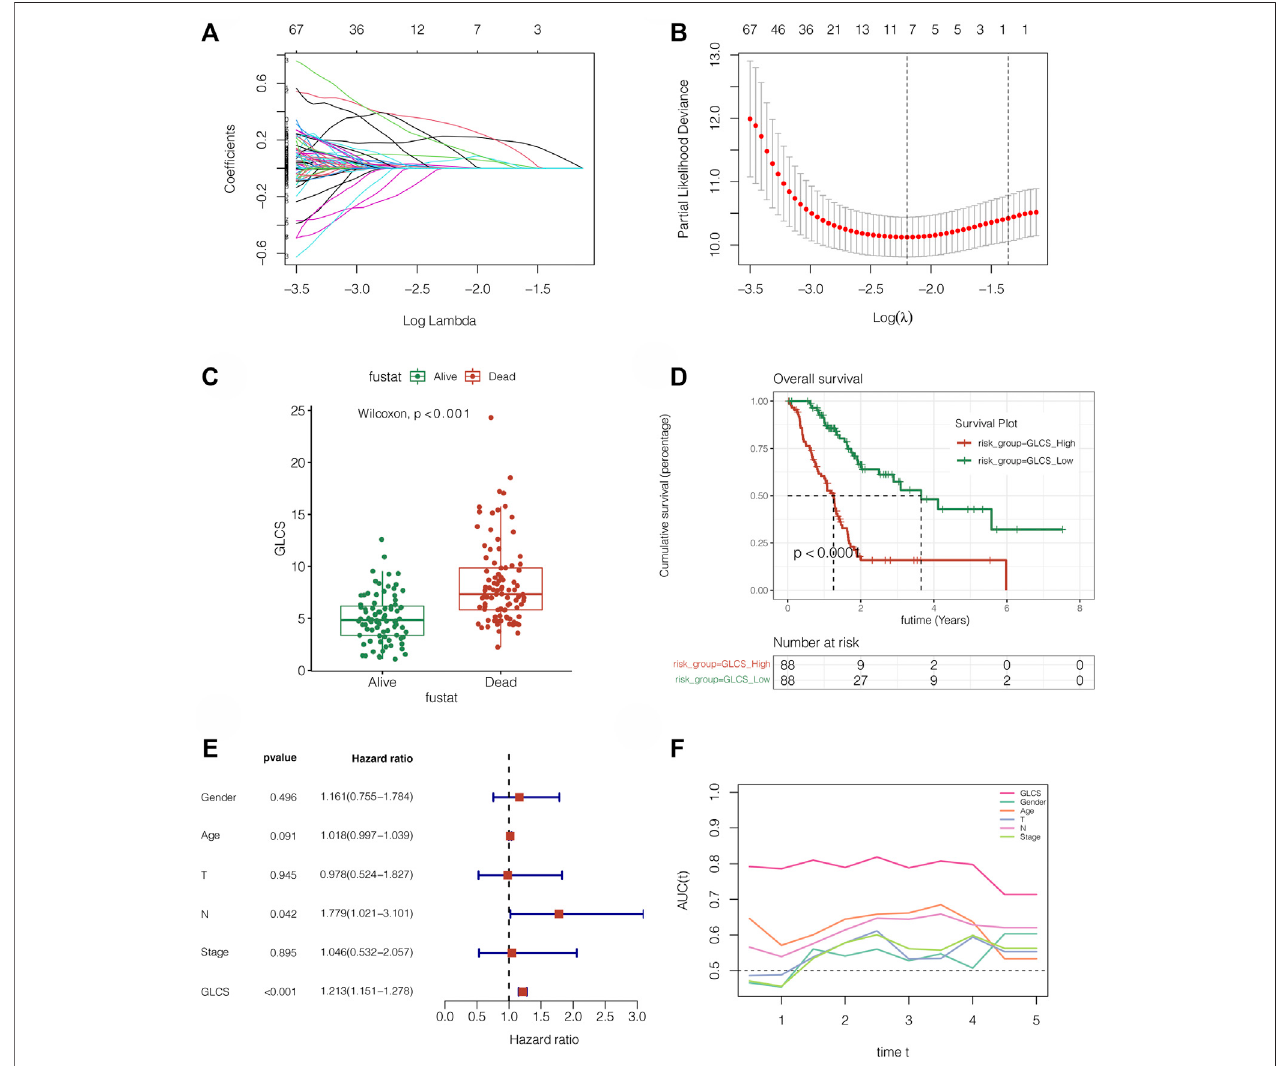
FIGURE3| GenesignaturewasconstructedinTCGAcohort. (A,B) LASSOCoxregressionwasusedtoidentifythemostimportantgenes,andtheoptimallambda was0.111. (C) GLCSwasobviouslyelevatedinthedeadPCpatients( p =2.3E-10). (D) SurvivalanalysisrevealsthatGLCS-highhasaworseprognosis( p < 0.0001). (E) MultivariateCoxanalysisrevealsthatGLCSwasanindependentprognosticfactor( p < 0.001). (F) AUCofGLCSandclinicalfeatures.TheAUCvalueofGLCSwashigher than that of other clinical features.